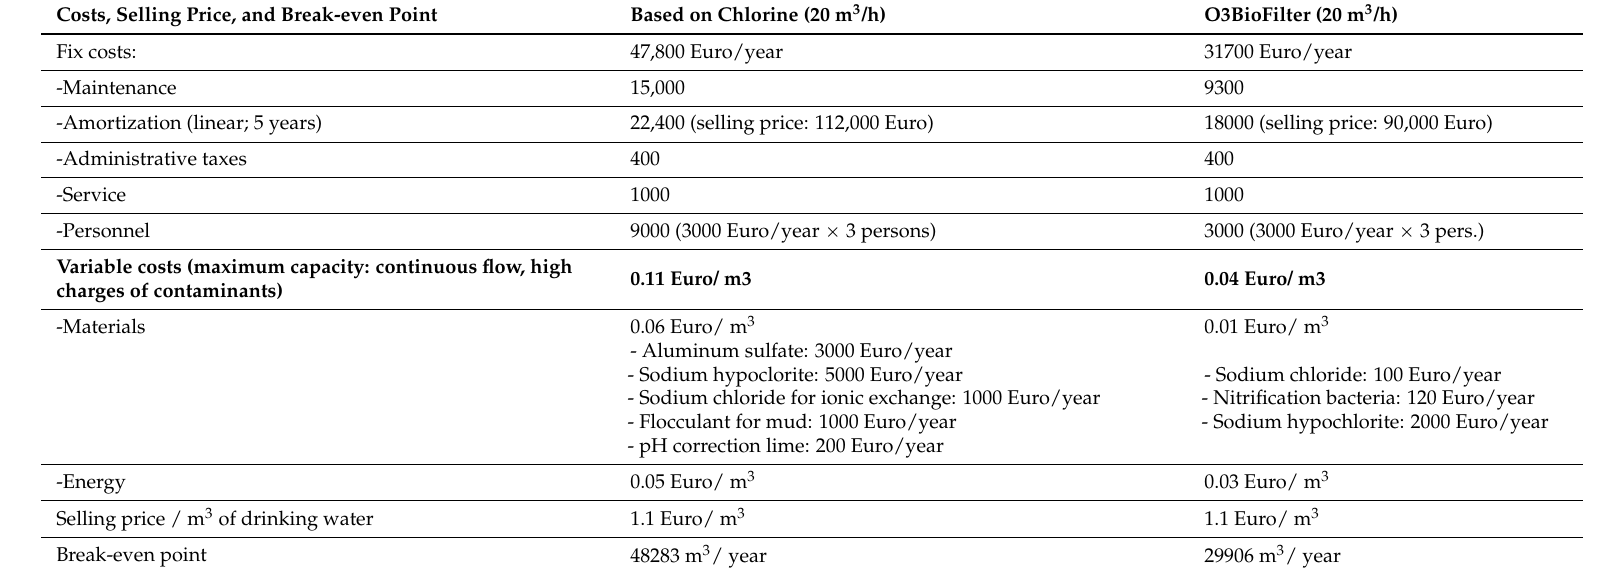
Table 7. Economic characteristics of chlorine and O3BioFilter technologies and their break-even